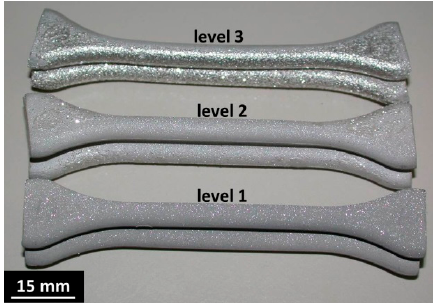
Figure 5. Identical MIM Mg ‐ 0.9Ca specimens sintered on three different levels in a furnace suffering from ±12 K temperature deviation.